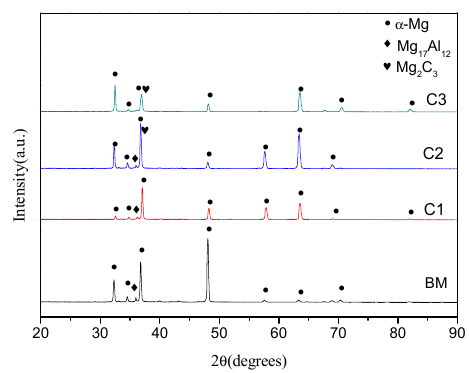
Figure 4. XRD patterns of different samples.